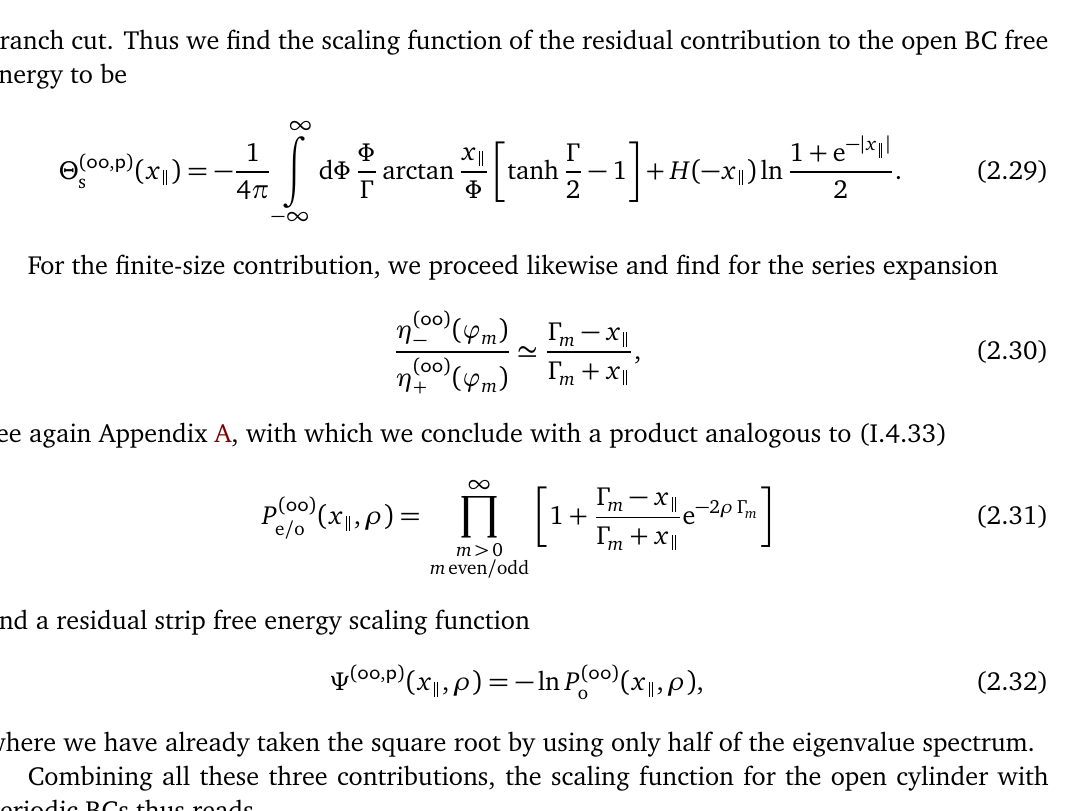
Figure 4: Scaling function Θ ρ ≤ 1. For ρ → 0 it converges against the well-known case of the thin film Θ ( oo ) see (2.56), marked as dotted black